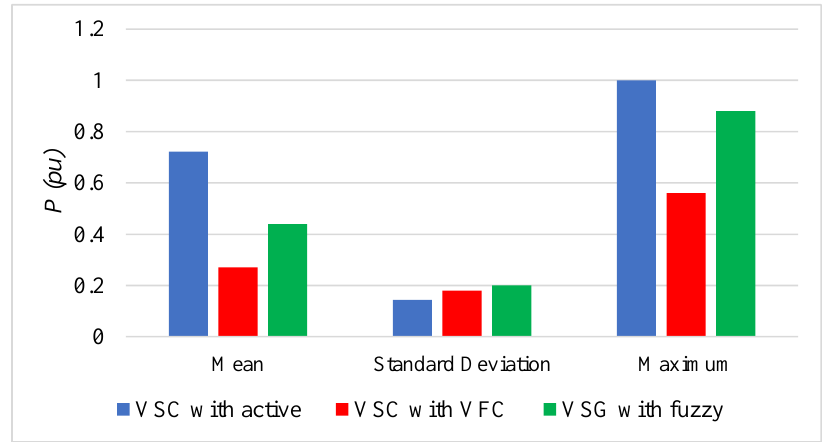
Figure 38. DER 1 output active power statistics for the various scenarios presented in Section 4.3.